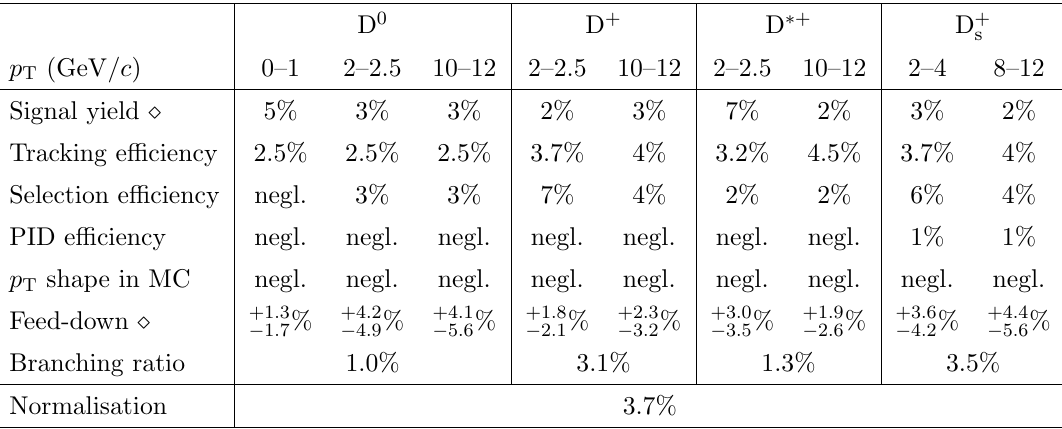
Table 1 . Summary of relative systematic uncertainties on D 0 , D + , D (cid:3) + , and D + sections. The event centrality-dependent uncertainties are marked by the symbol (cid:5)